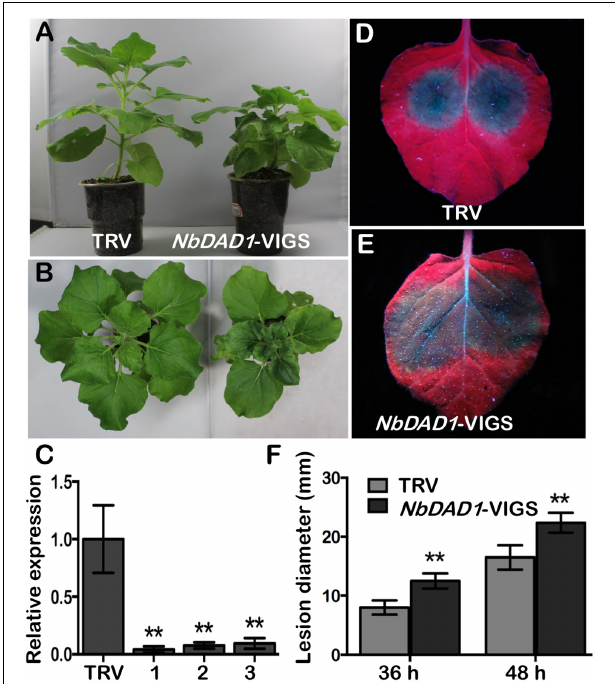
FIGURE 8 | Silencing of NbDAD1 in N. benthamiana reduces resistance to P. parasitica . (A,B) Side- and top- view of the TRV-infected control and NbDAD1 silencing plants. (C) Relative expression of NbDAD1 in N. benthamiana plants inoculated with TRV and three NbDAD1 knock-down plants. The samples were collected 2 weeks after infection. N. benthamiana NbEF1 α gene was used as reference for normalization. Data are the means ± SD calculated from three replicates. ∗∗ P < 0.01. (D,E) Leaf phenotypes of TRV control and NbDAD1 -VIGS after P. parasitica zoospores inoculation. Pictures were taken under UV illumination at 48 hpi. The experiments were repeated three times with similar results and representative images are shown. (F) Average lesion size of NbDAD1 knock-down leaves and TRV control after P. parasitica zoospores inoculation. Averages were calculated from at least 10 lesions per construct. Data are the means ± SD. Data were analyzed by using Student’s t -tests ( ∗∗ P <